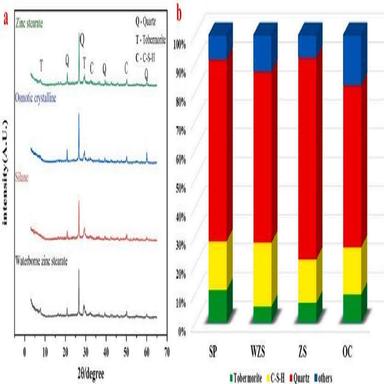
Effect of different water-repellents on the hydration products of AAC: (a) XRD patterns of test samples amended with different kinds of water-repellents, (b) Phase content of AAC samples mixed with different types of water-repellents.